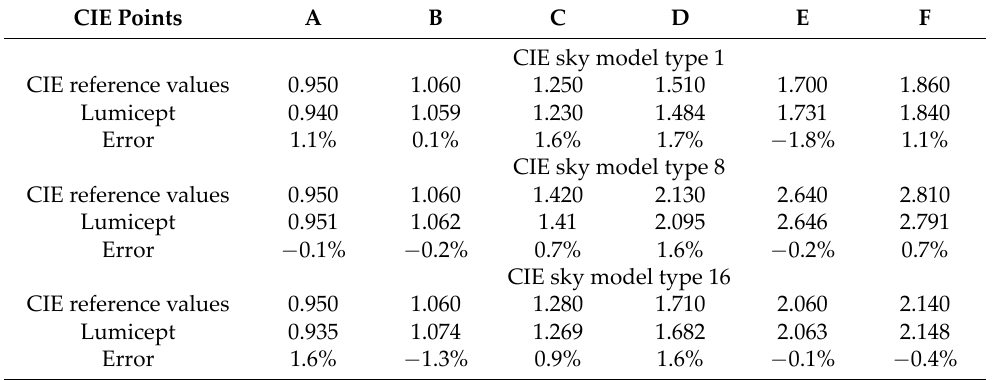
Table 9. Results of test 5.11 from CIE 171:2006. Points G–N on the floor (Figure 9).